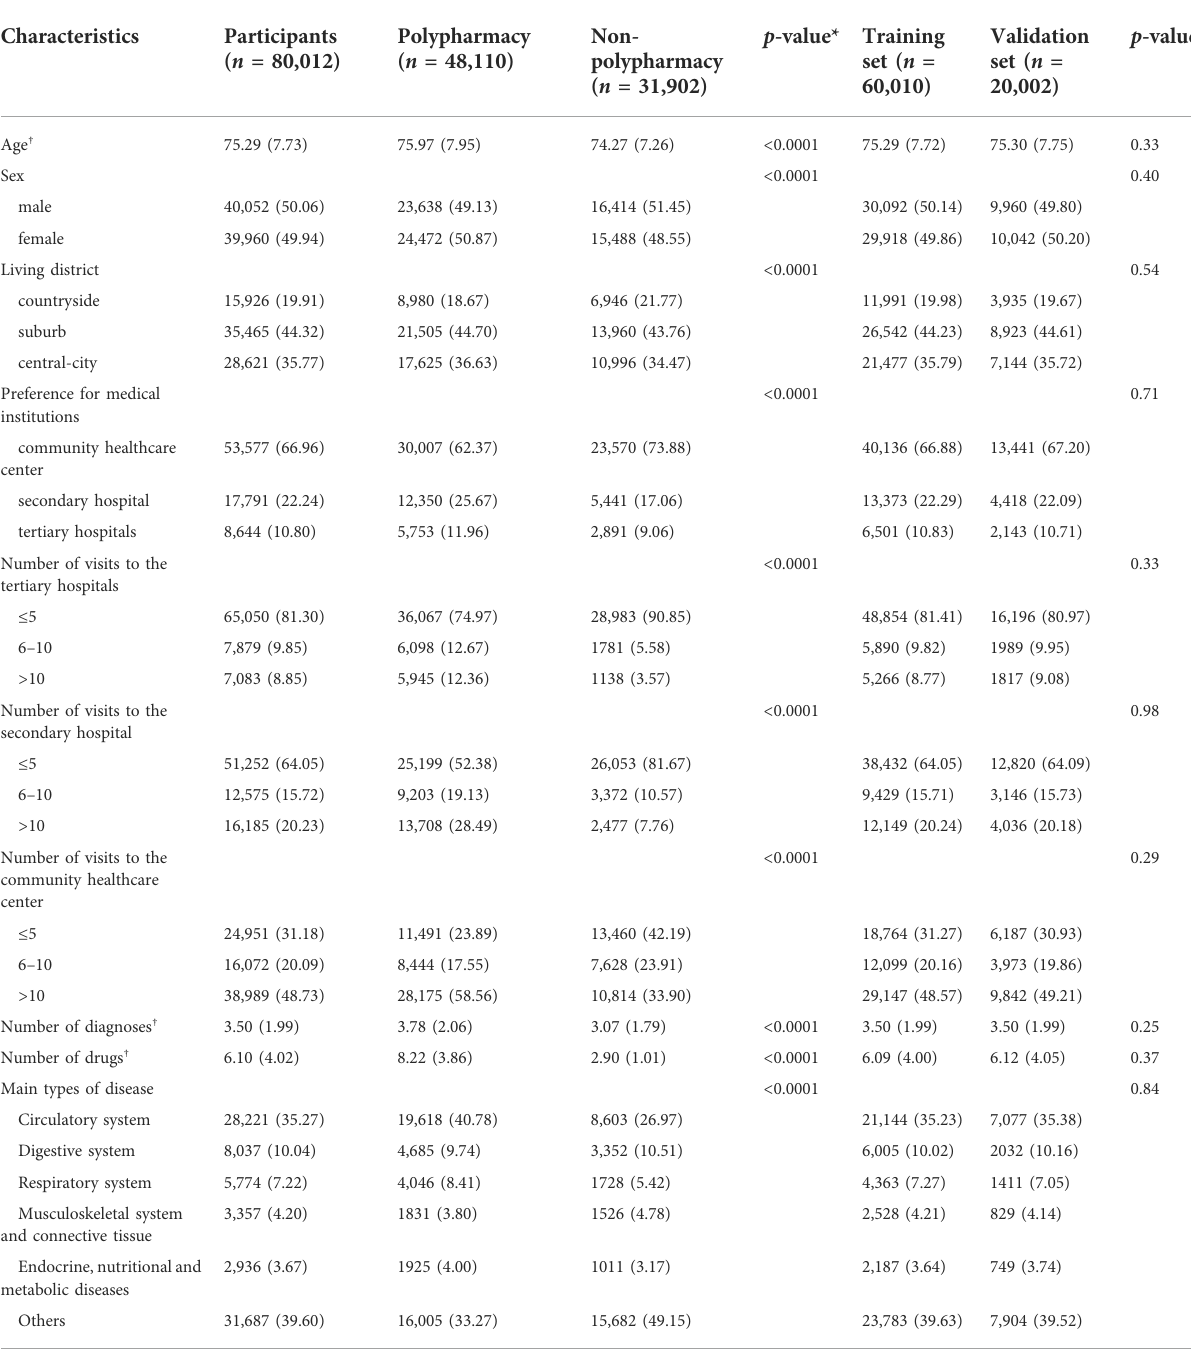
TABLE 1 Characteristics and factors of the